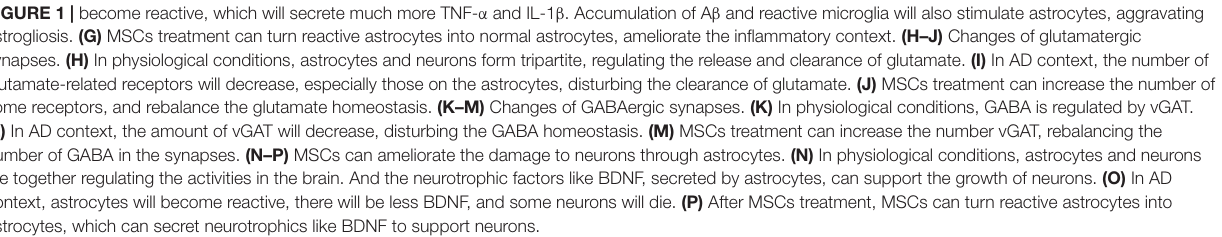
FIGURE 1 | become reactive, which will secrete much more TNF- α and IL-1 β . Accumulation of A β and reactive microglia will also stimulate astrocytes, aggravating astrogliosis. (G) MSCs treatment can turn reactive astrocytes into normal astrocytes, ameliorate the inflammatory context. (H–J) Changes of glutamatergic synapses. (H) In physiological conditions, astrocytes and neurons form tripartite, regulating the release and clearance of glutamate. (I) In AD context, the number of glutamate-related receptors will decrease, especially those on the astrocytes, disturbing the clearance of glutamate. (J) MSCs treatment can increase the number of some receptors, and rebalance the glutamate homeostasis. (K–M) Changes of GABAergic synapses. (K) In physiological conditions, GABA is regulated by vGAT. (L) In AD context, the amount of vGAT will decrease, disturbing the GABA homeostasis. (M) MSCs treatment can increase the number vGAT, rebalancing the number of GABA in the synapses. (N–P) MSCs can ameliorate the damage to neurons through astrocytes. (N) In physiological conditions, astrocytes and neurons are together regulating the activities in the brain. And the neurotrophic factors like BDNF, secreted by astrocytes, can support the growth of neurons. (O) In AD context, astrocytes will become reactive, there will be less BDNF, and some neurons will die. (P) After MSCs treatment, MSCs can turn reactive astrocytes into astrocytes, which can secret neurotrophics like BDNF to support